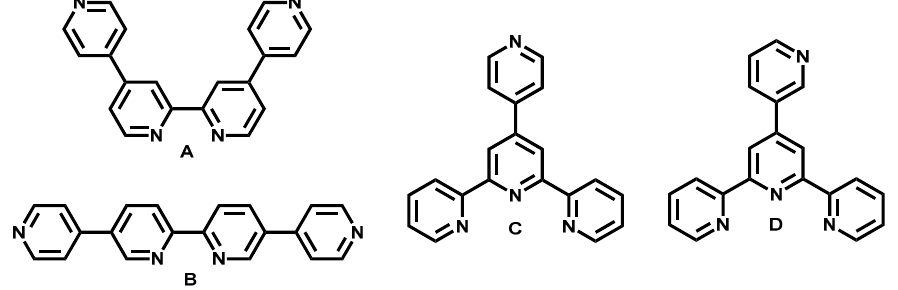
Figure 1. 2,2-Bipyridine (bipy) and 2,2 ′ :6 ′ ,2 ″ -terpyridine (terpy) chelators conjugated to pyridyl units, 4,4 ′ :2 ′ ,2 ″ :4 ″ ,4 ″′ -quaterpyridine ( A ), 4,5 ′ :2 ′ ,2 ″ :5 ″ ,4 ″′ -quaterpyridine ( B ), 4 ′ -(4-pyridinyl)-2,2 ′ :6 ′ ,2 ″ -terpyridine ( C ) and 4 ′ -(3-pyridinyl)-2,2 ′ :6 ′ ,2 ″ -terpyridine ( D ).